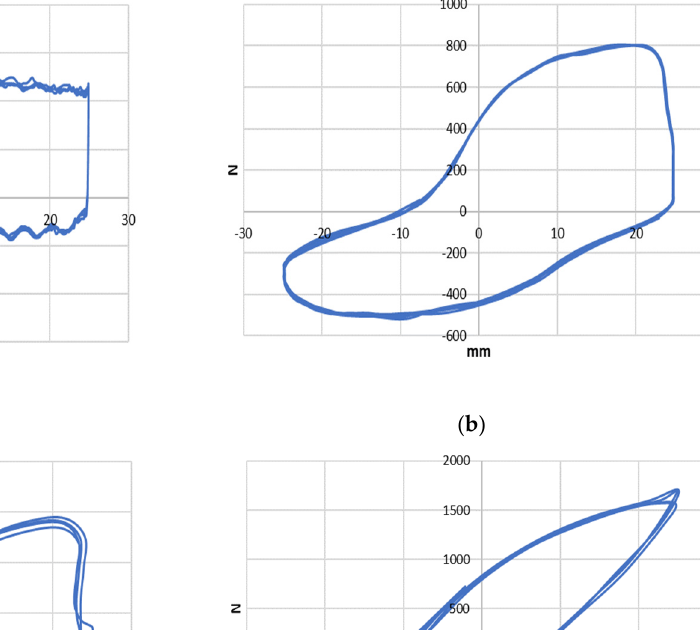
Figure 3. Force-displacement hysteresis loops, with the applied velocity of the maximum rated ve- locity at ( a ) 1%, ( b ) 25%, ( c ) 50%, ( d ) 75% and ( e ) 100%. Table 2. The normalized force vs. normalized velocity. No./ Index Normalized Velocity [%]